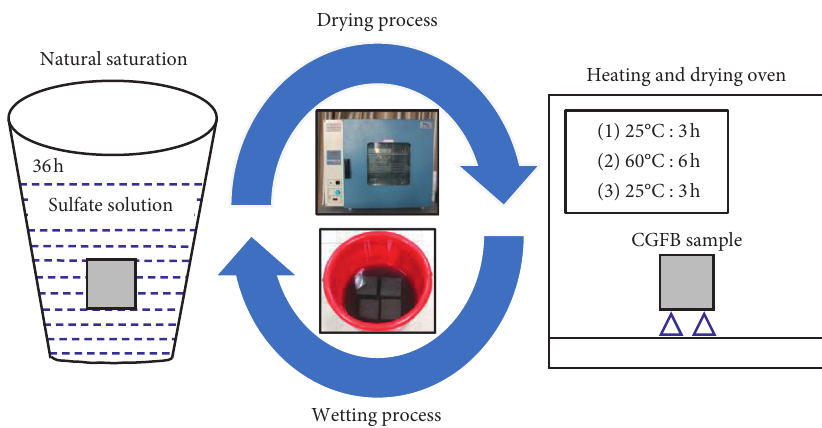
Figure 2: Schematic illustration of the cyclic drying-wetting